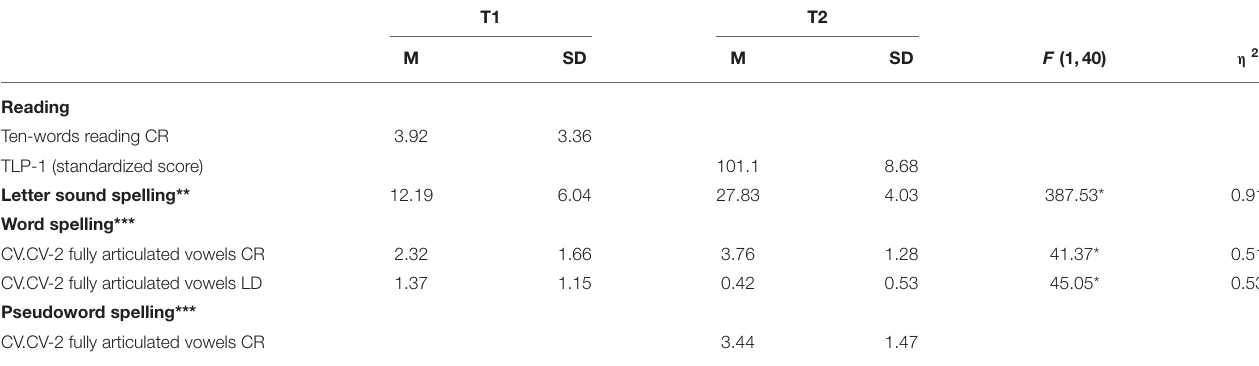
TABLE 2 | Scores on ancillary alphabetic tasks at T1 and at T2. T1 T2 M SD M SD F (1,40)